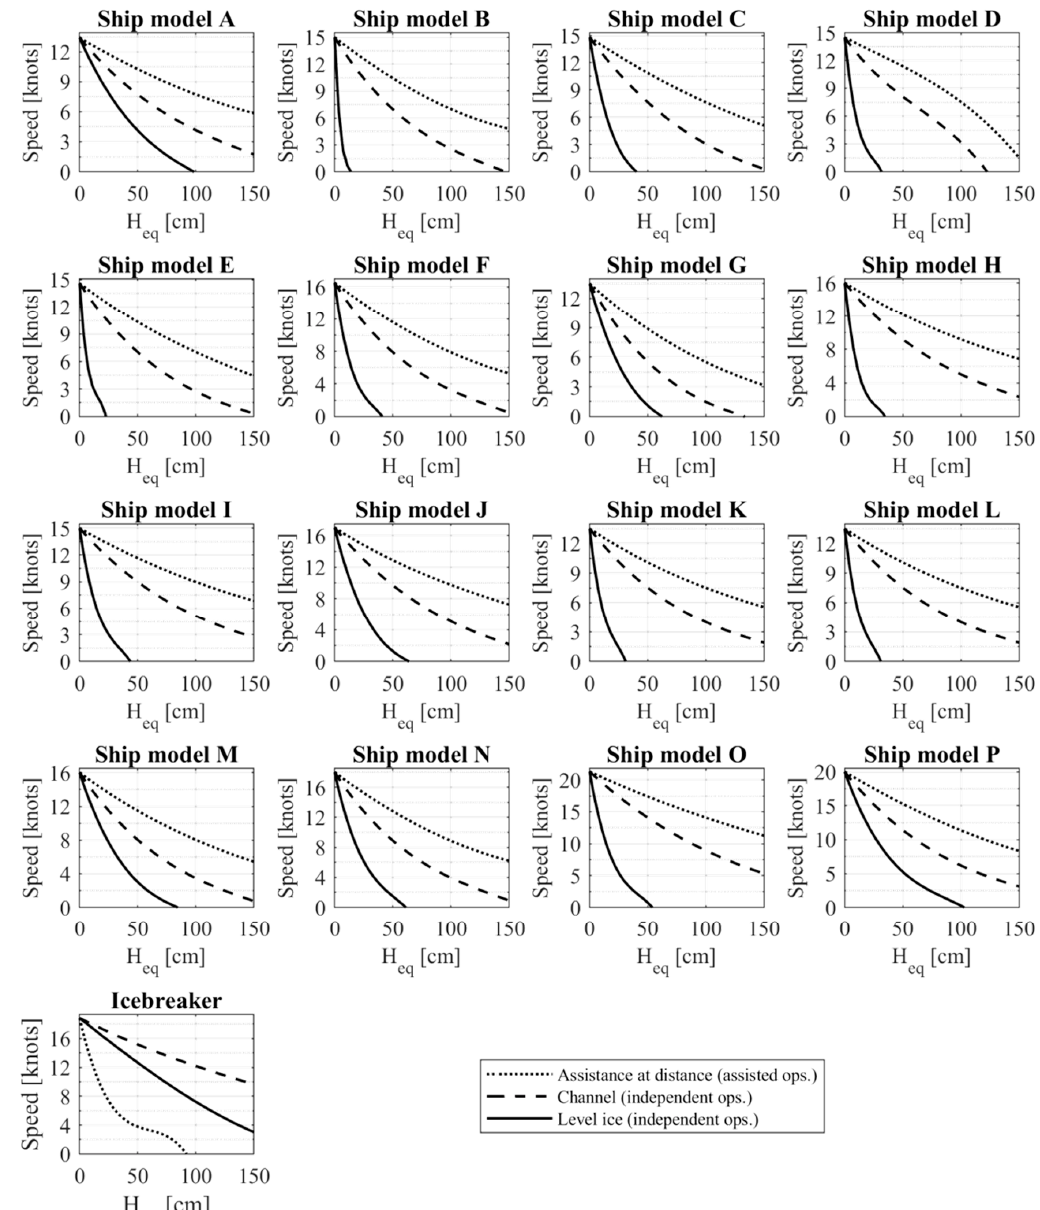
Figure 5. Ship model-specific hv curves for three different operation modes: icebreaker (IB) assistance at distance, operation in a brash ice channel, and independent operation in level ice [26].